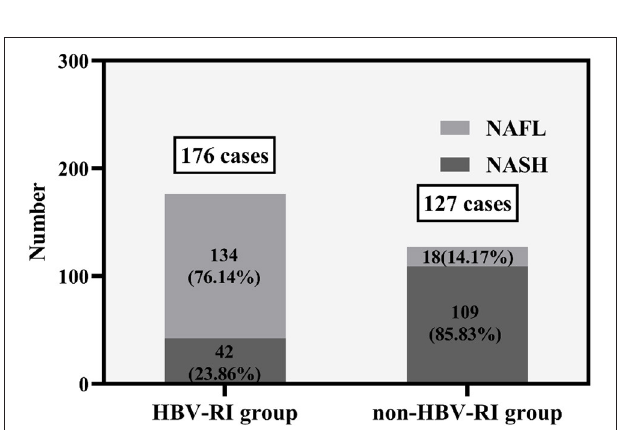
FIGURE 6 | The NAS scores between the HBV-RI group and the non-HBV-RI group. HBV-RI group, HBV-related inflammation group; non-HBV-RI group, non-HBV-related inflammation group; NAFL, nonalcoholic fatty liver; NASH, nonalcoholic steatohepatitis (NASH).